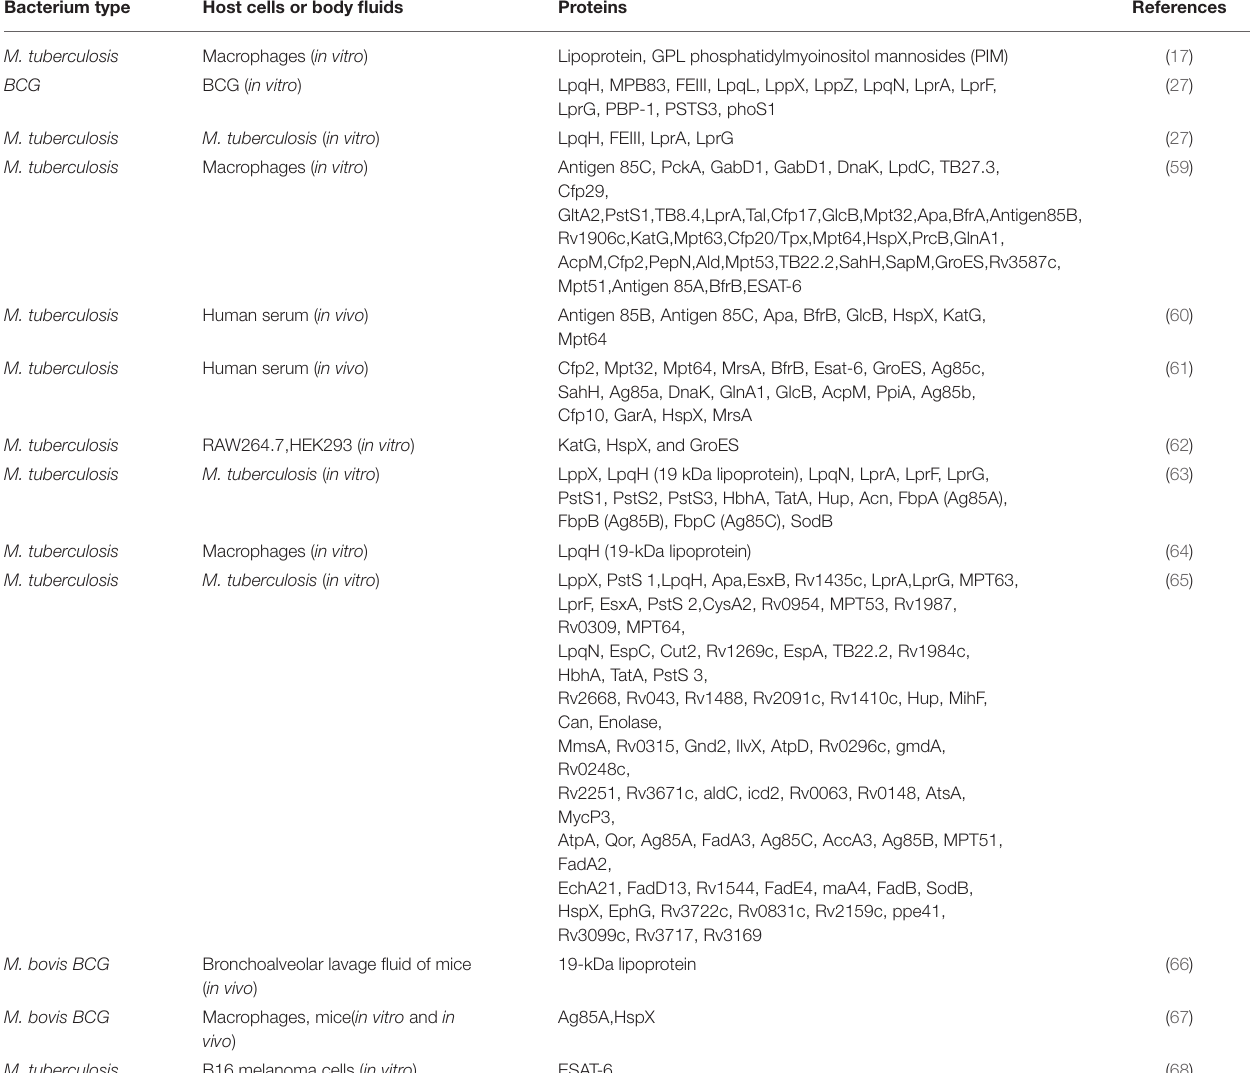
TABLE 1 | Mycobacterial components carried by